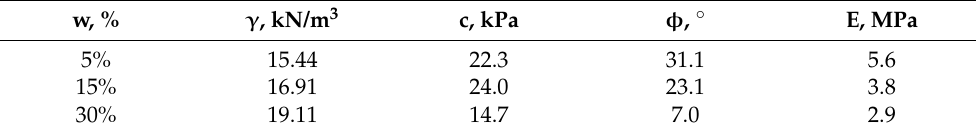
Table 1. Physical–mechanical properties of the artificial soil.